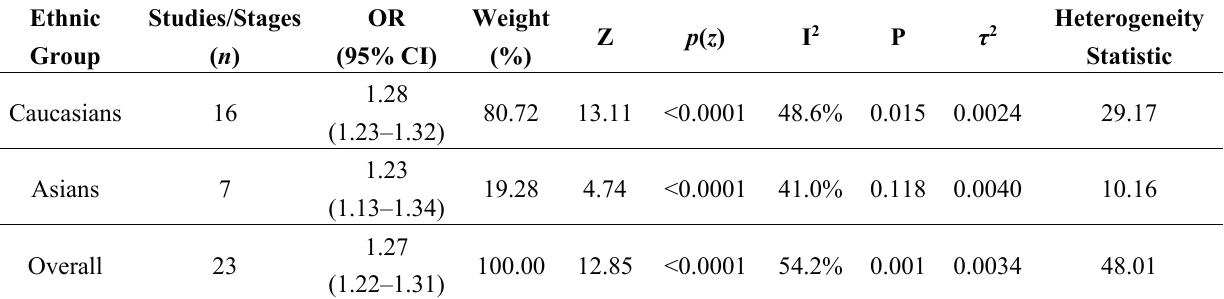
Table 5. Heterogeneity test of rs4977574 association studies by subgroup